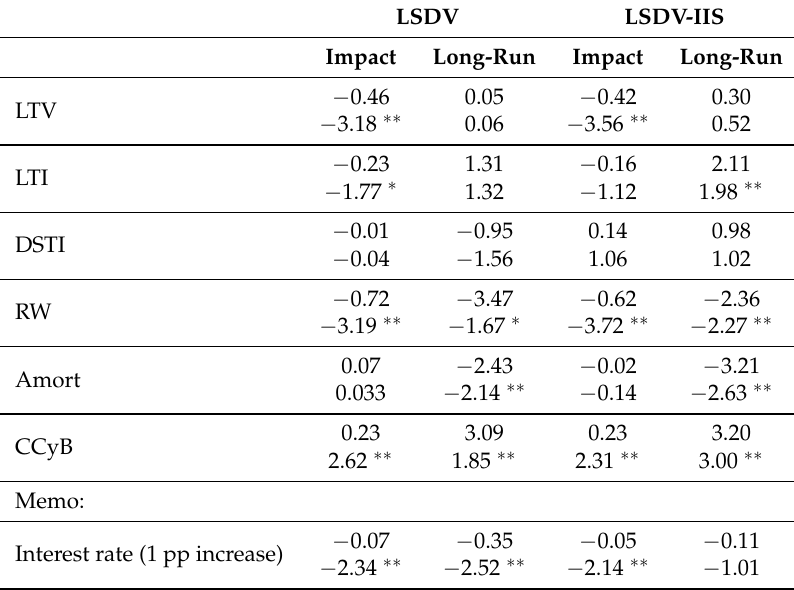
Table 2. Credit growth. Estimated (LSDV and LSDV-IIS) effects for LTV, LTI, DSTI, RW, Amort and CCyB. Results for the central bank rate shown in the memo part of the table. t-values are shown below the estimated impact and long-run effects. Statistical significance (two sided test) is indicated by ∗∗ (5% level) and ∗ (10%